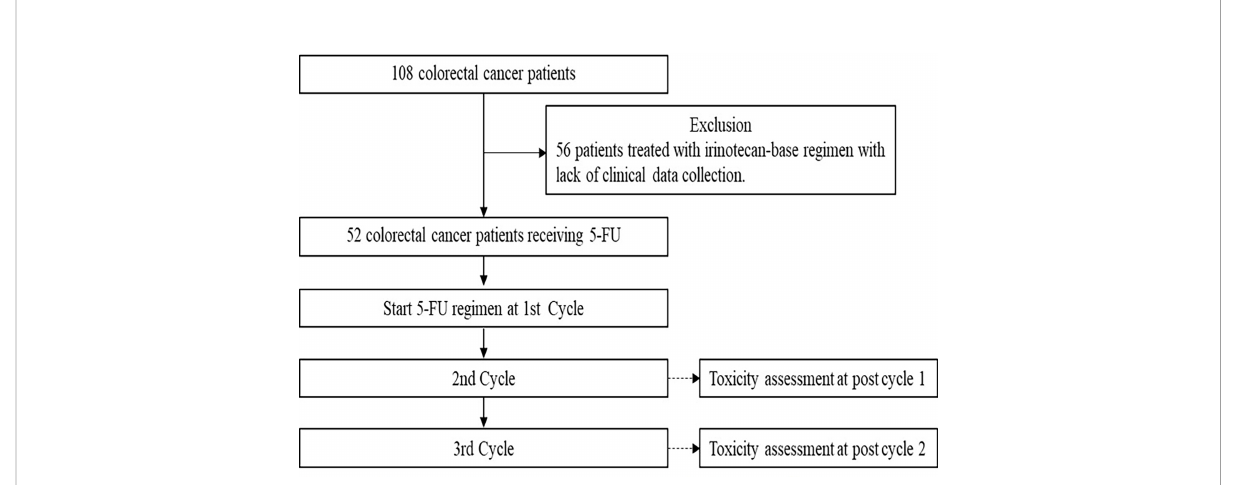
FIGURE 1 Flow chart for patient screening. A total of 108 metastatic colorectal cancer patients were genotyped for generic polymorphisms and 56 patients who did not treated with 5- fl ourouracil-based chemotherapy were excluded. Of the 52 patients treated with 5- fl ourouracil-based chemotherapy were included in this